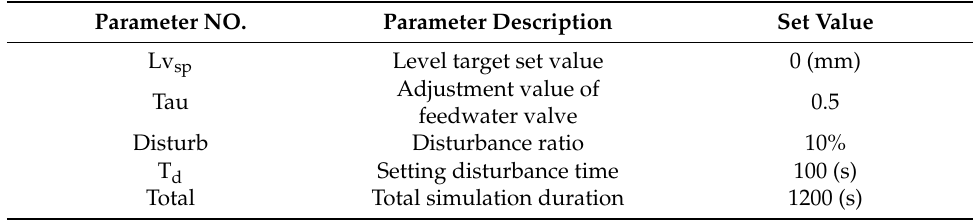
Table 2. Parameters settings of cascade PID control system.